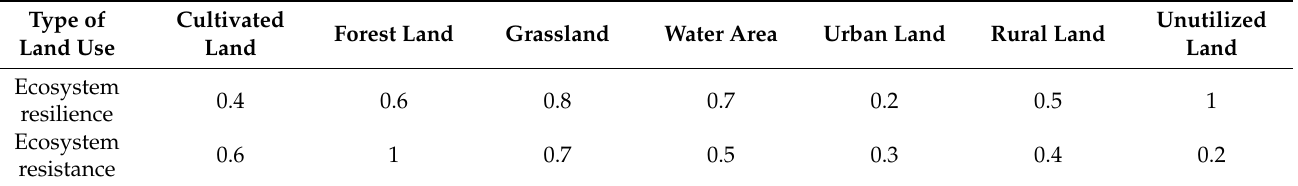
Table 3. Principles and methods for assessing the ecosystem service functions of each ecosystem in the central Yunnan urban